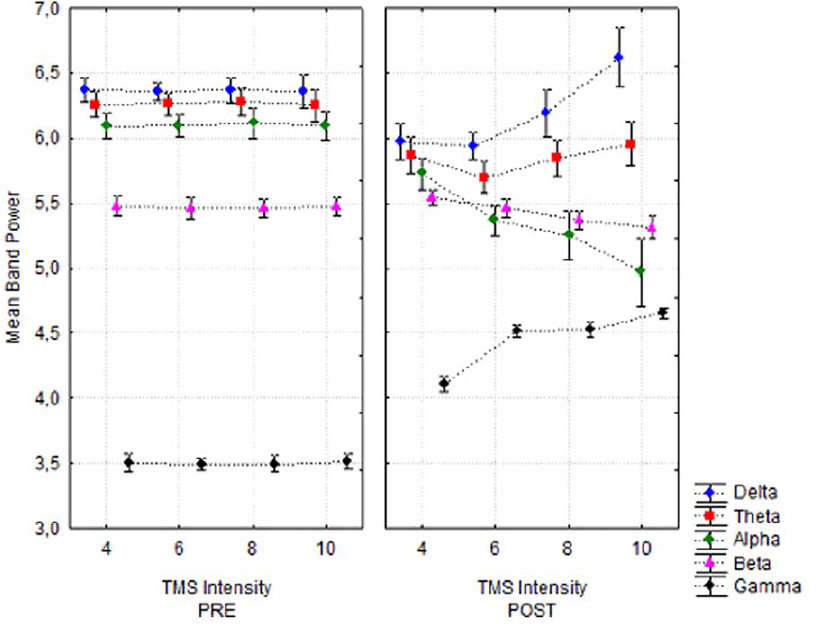
Figure 2. Interaction of TIME*TMS-INTENSITY*FREQUENCY_BAND. Mean band power values are given in V/ ! Hz and represent an average over the